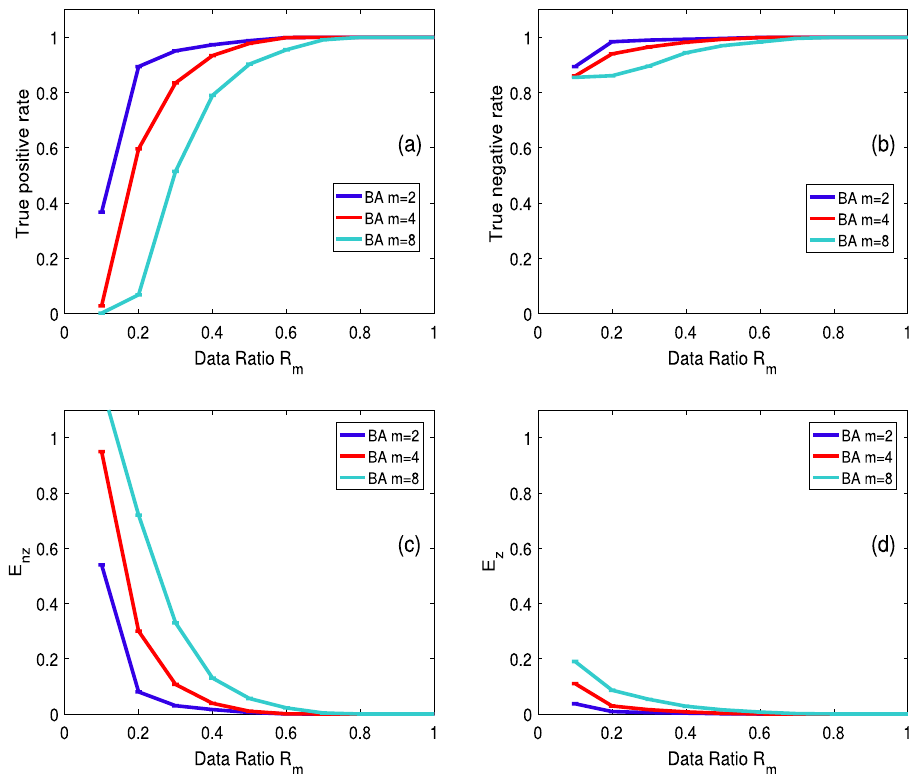
Figure 3. Identification performance with varying data ratio R m in three 100-node BA networks, where ε = 0.01 , and the density parameter is given as m = 2 , 4, and 8